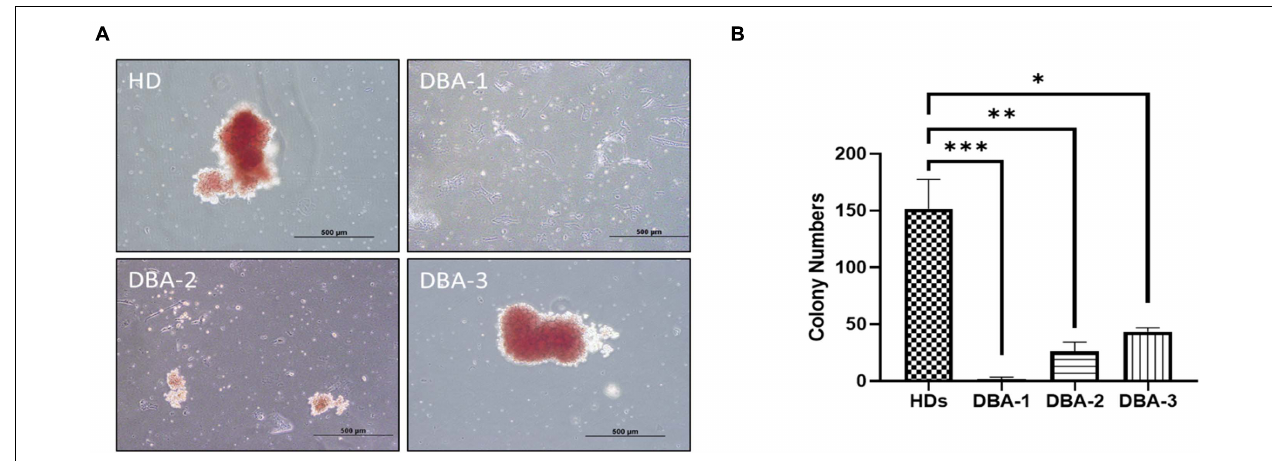
FIGURE 1 | Erythroid colony formation assay. (A) DBA patient samples had diminished/lack of colony forming potential (B) and had significantly low number of erythroid colonies. HD: Healthy donor ( ∗ p : 0.0015; ∗∗ p : 0.0007; ∗∗∗ p :